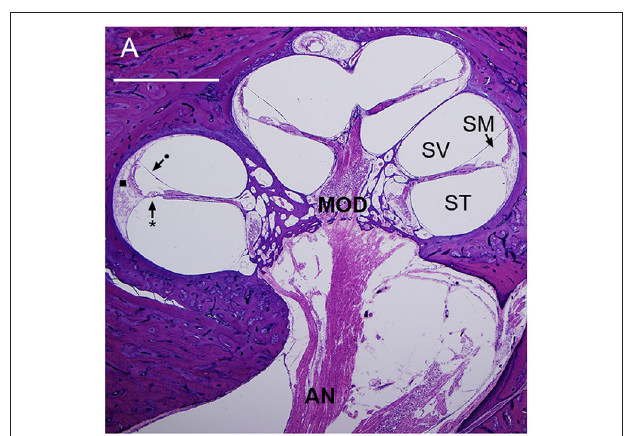
FIGURE 1 | Mid-modiolar section of a human cochlea showing the modiolus (MOD), containing spiral ganglion neurons with axons to and from the auditory nerve (AN). The basilar membrane (*) and Reissner’s membrane ( • ) define three fluid-filled spaces: scala tympani (ST), scala media (SM), and scala vestibuli (SV). The lateral wall ( (cid:4) ) connects the basilar membrane to the otic capsule (